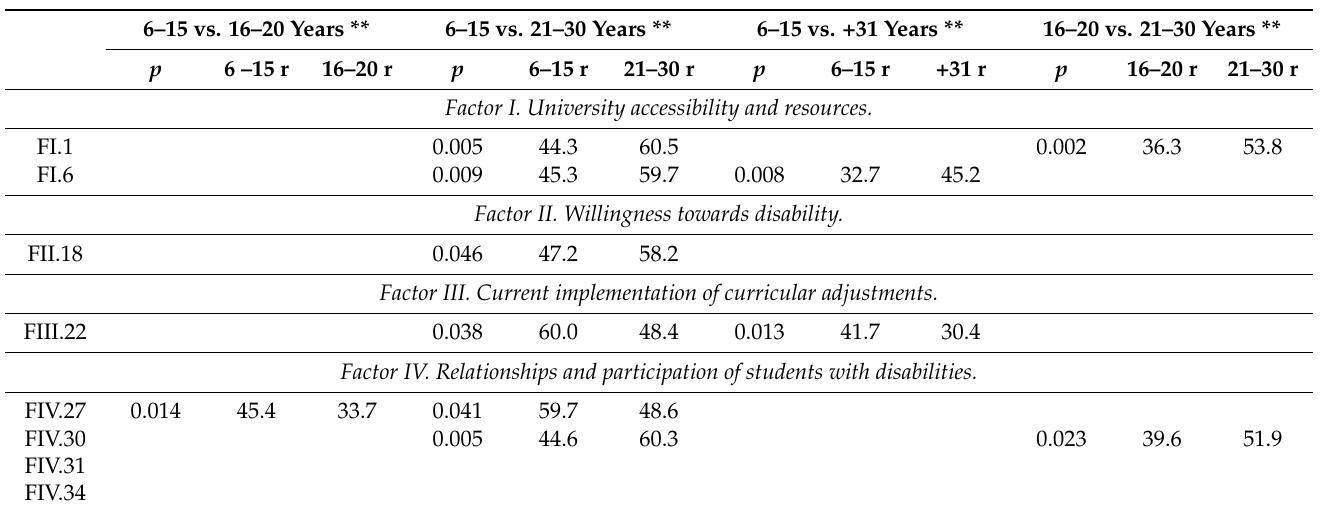
Table 11. Post hoc Kruskal–Wallis analysis by sections of teaching seniority.